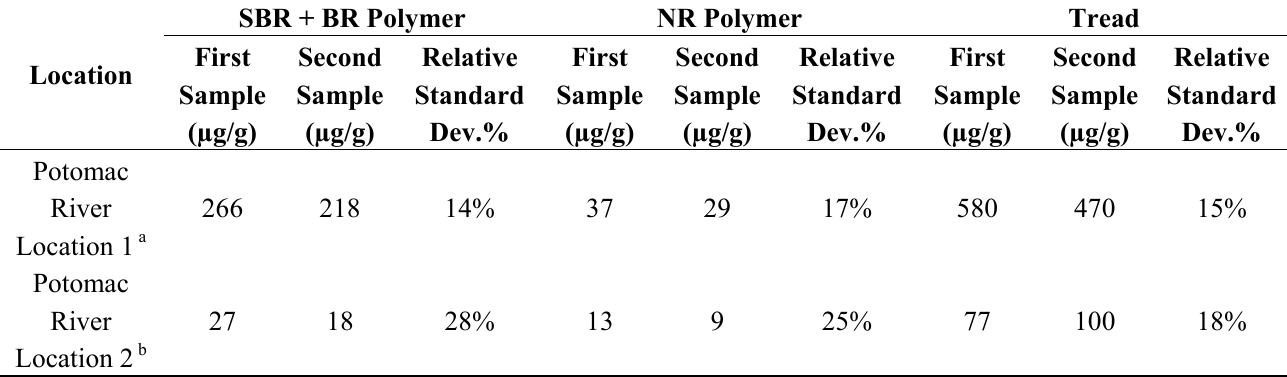
Table 5. Field duplicate analysis of two sediment sample locations (dry weight